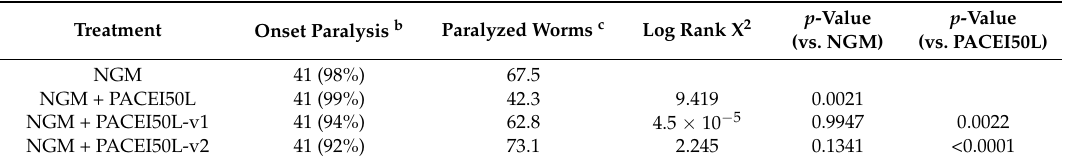
Figure 3. The body paralysis of C. elegans CL4176 measured after the temperature up-shift in nematodes treated with or without peptides; worms without temperature induction were included as the negative control (dashed line). Time refers to the hours after A β 1–42 expression induced by the temperature up-shift. ( A ) Non-treated worms (black line); treated-worms with 0.1 µ g/mL of PACEI50L (red line), 0.1 µ g/mL PACEI50L-v1 (blue line), and 0.1 µ g/mL PACEI50L-v2 (purple line); data are the average of three independent trials. ( B ) Non-treated worms (black line); treated-worms with 0.1 µ g/ml of PKH11 (red line) and 0.1 µ g/mL PKH11-v1. Table 5. Effects of the PACEI50L, PACEI50L-v1, and PACEI50L-v2 treatments at 0.1 µ g/mL on CL4176 paralysis and statistical analyses of the paralysis curves a .